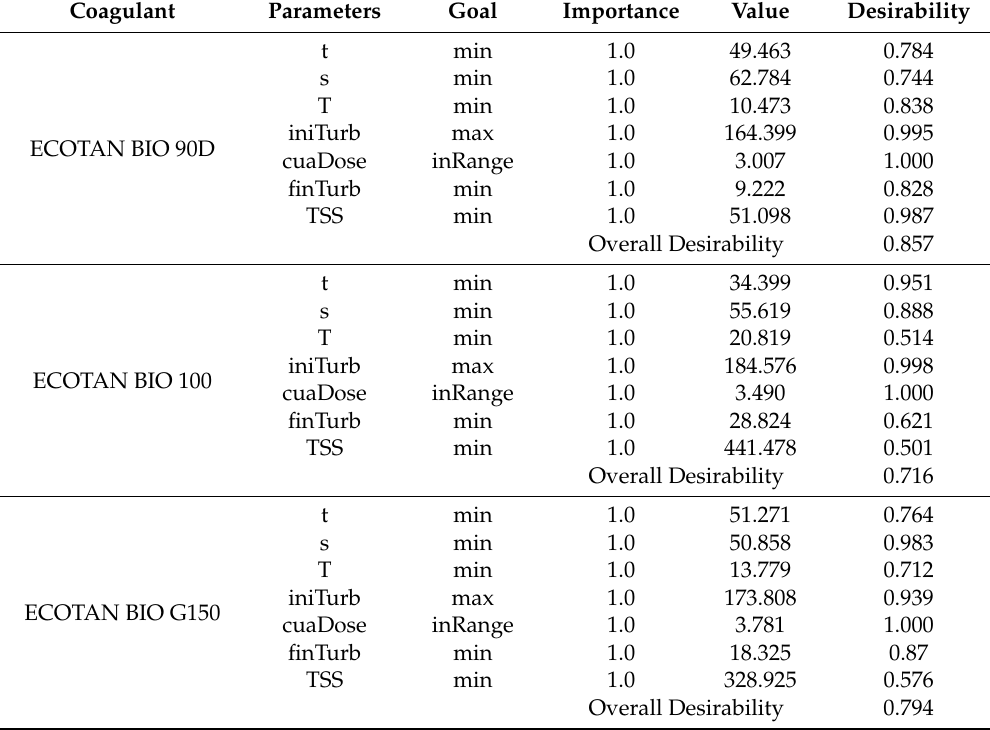
Table 16. The third clarification optimization scenario: the energy consumption is minimized to obtain the highest efficiency of turbidity removal and TSS, when the sample water is very turbid.